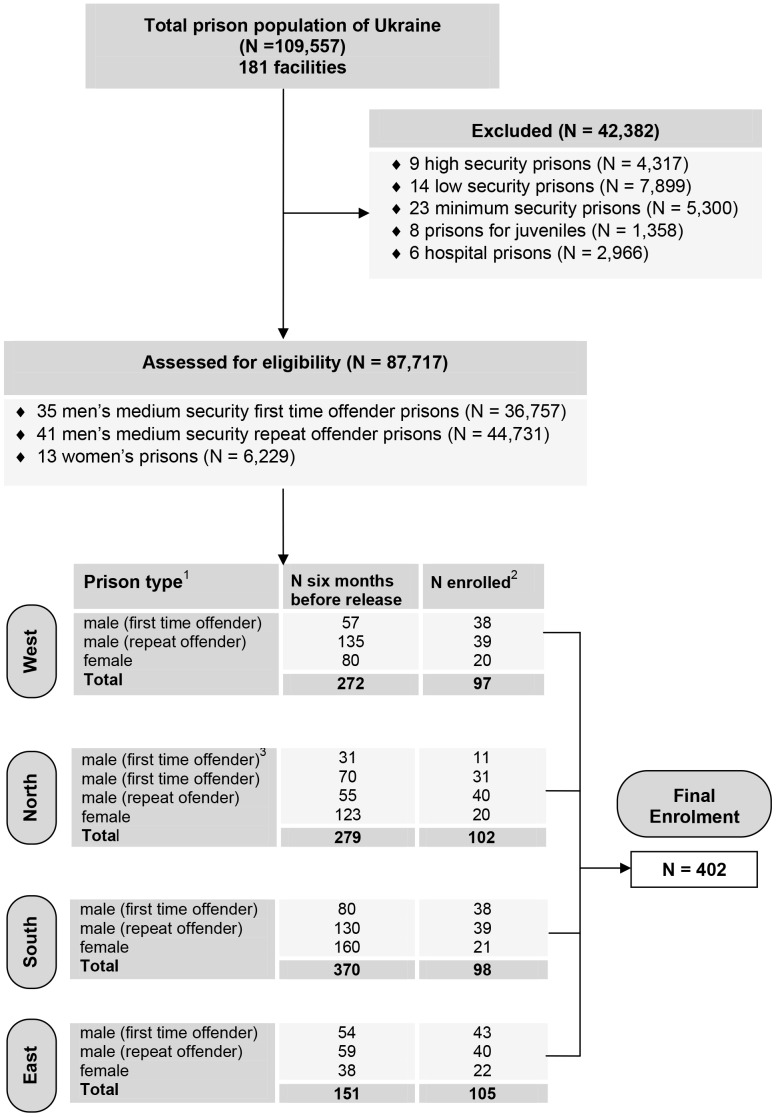
Selection of representative survey sites.
Figure 1 shows the flow of participant selection. All data are current as of May 1, 2012. 1The administrative divisions (oblasts) included in each region were Kyivs’ka, Chernihivs’ka, Zhytomyrs’ka (north); Odes’ka (south); Donets’ka (east); Lvivs’ka (west). 224 interviewees decided not to participate for the following reasons: already knew status (N = 7); about to transfer elsewhere (N = 6); cannot give blood (N = 5); transferred to isolation unit (N = 3); felt too sick (N = 3). 3Discontinued enrolment due to poor cooperation from prison staff.